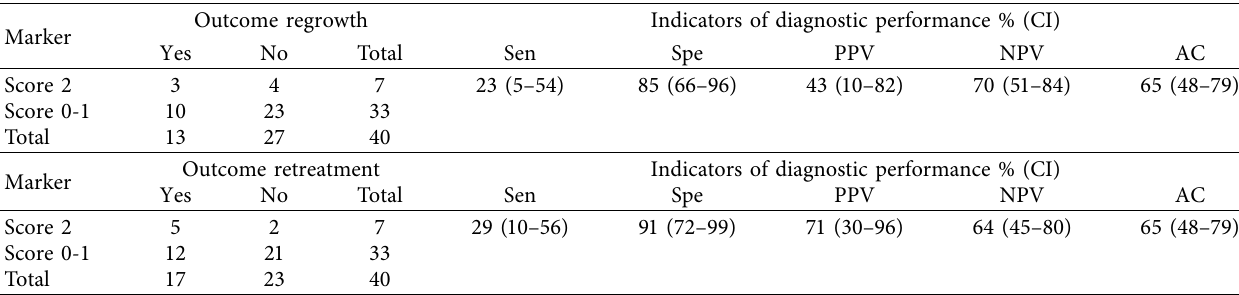
Table 4: Predictive value of composite biomarker CK-19+Ki-67 for response to thermal